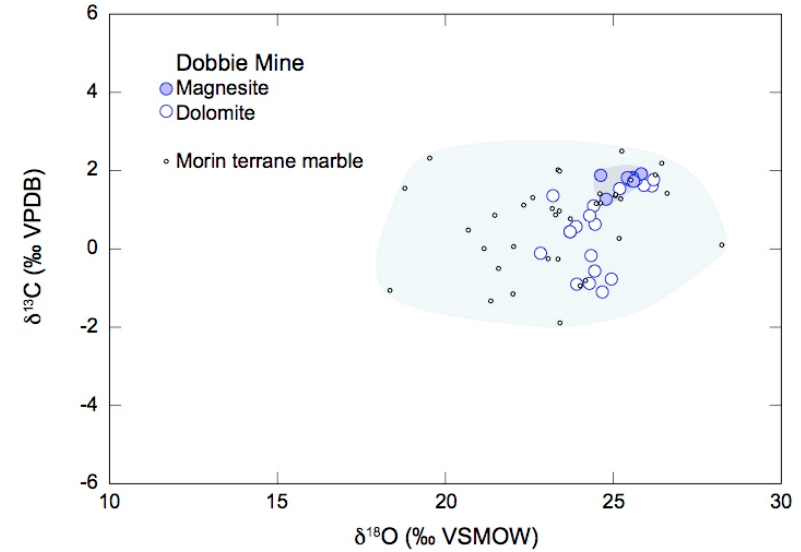
Figure 10. Oxygen and carbon isotopes of samples from the Dobbie mine and regional Morin terrane marbles [14].